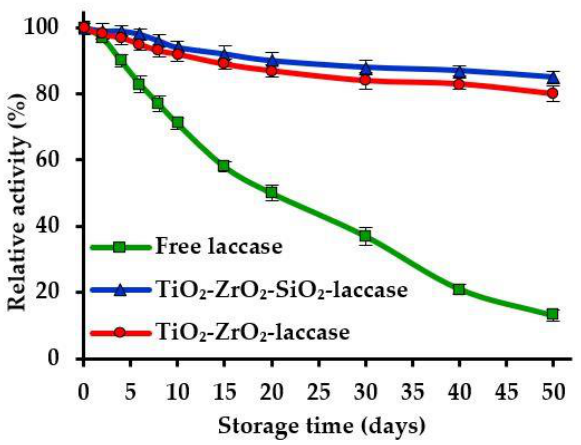
Figure 4. Storage stability of free and immobilized laccase after 50 days of storage time.